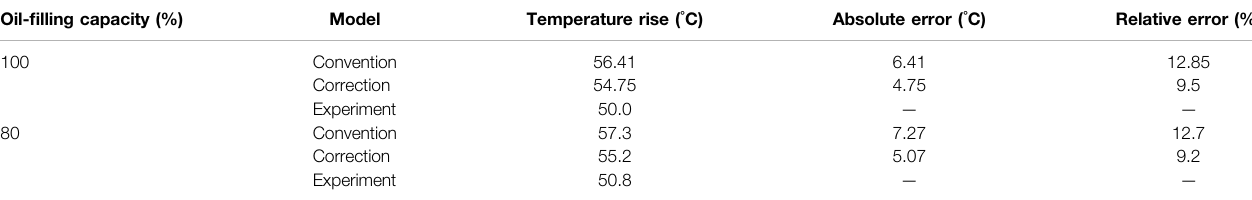
TABLE 3 | Corrected results